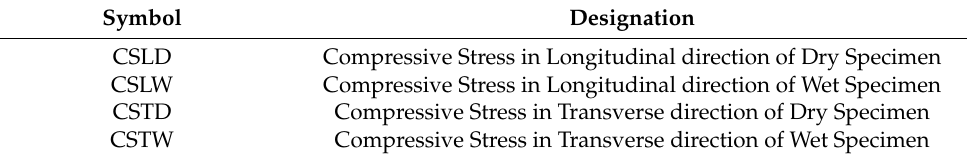
Table 8. Nomenclature for coupons developed for compression testing.